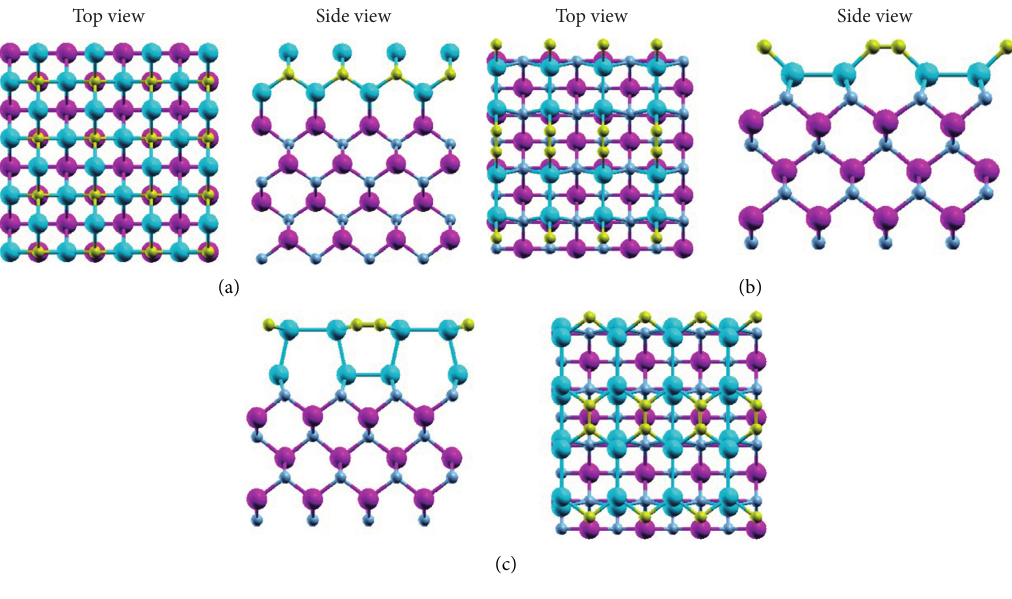
Figure 4: Different GeC surfaces: (a) formation of a GeC bilayer on the ideal Ga-terminated surface (GaN/GeC), (b) the C dimers’ formation on the Ge-terminated surface (Ge-term-C), and (c) GeC chair-like layer.